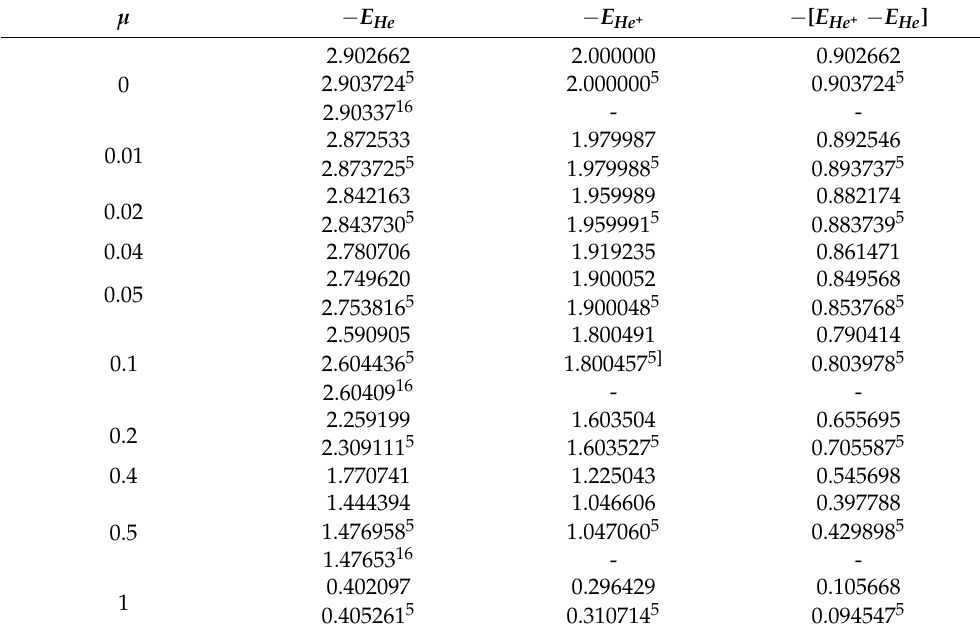
Table 2. Ground state energies of the helium atom under effective ECSCP in dense quantum plasma. The He + threshold energies and ionization potential [ E He + − E He ] of He are also